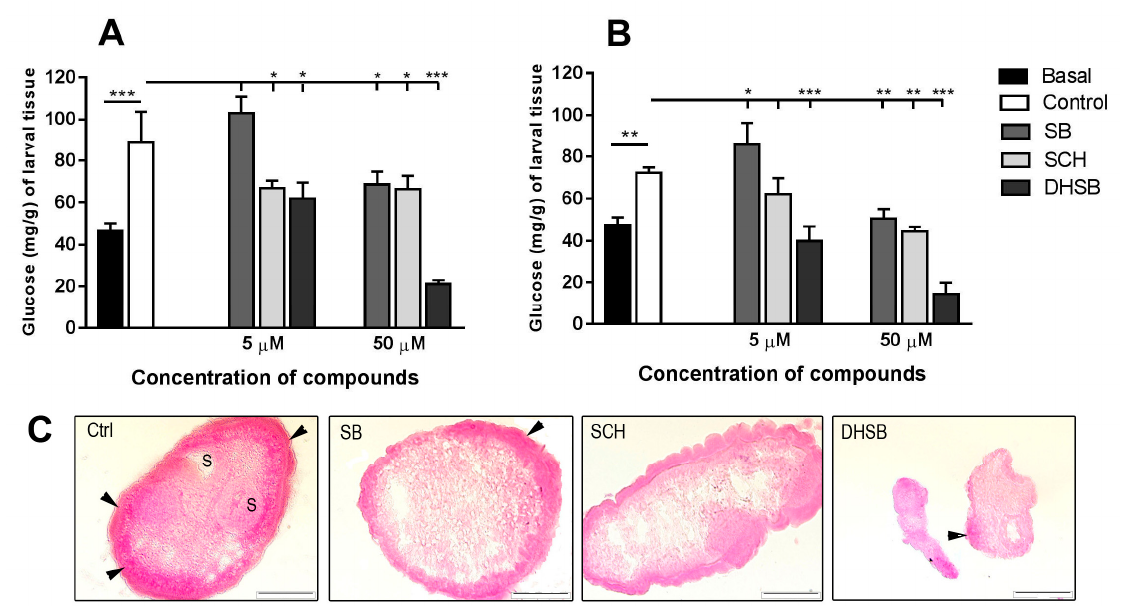
Figure 4. Concentration of glucose in larvae after isolation from mouse (basal), in control group and after treatment with SB, SCH and DHSB at 5 µ M and 50 µ M concentration for 72 h under aerobic ( A ) and hypoxic ( B ) conditions. Significantly different values from corresponding controls are shown as * p < 0.05, ** p < 0.01, *** p < 0.001. ( C ) Representative images of cryosections of larvae from hypoxic incubation after exposure to 50 µ M concentration of FLs. Glycogen (arrows) was mostly localized as dark purple granules in sub-tegumental parts of control, SB and SCH-treated larvae, and was lacking in DHSB-treated larvae. Scale bar = 100 µ m, Ctrl (control), (SB) silybin; (SCH) silychristin; (DHSB) dehydrosilybin.